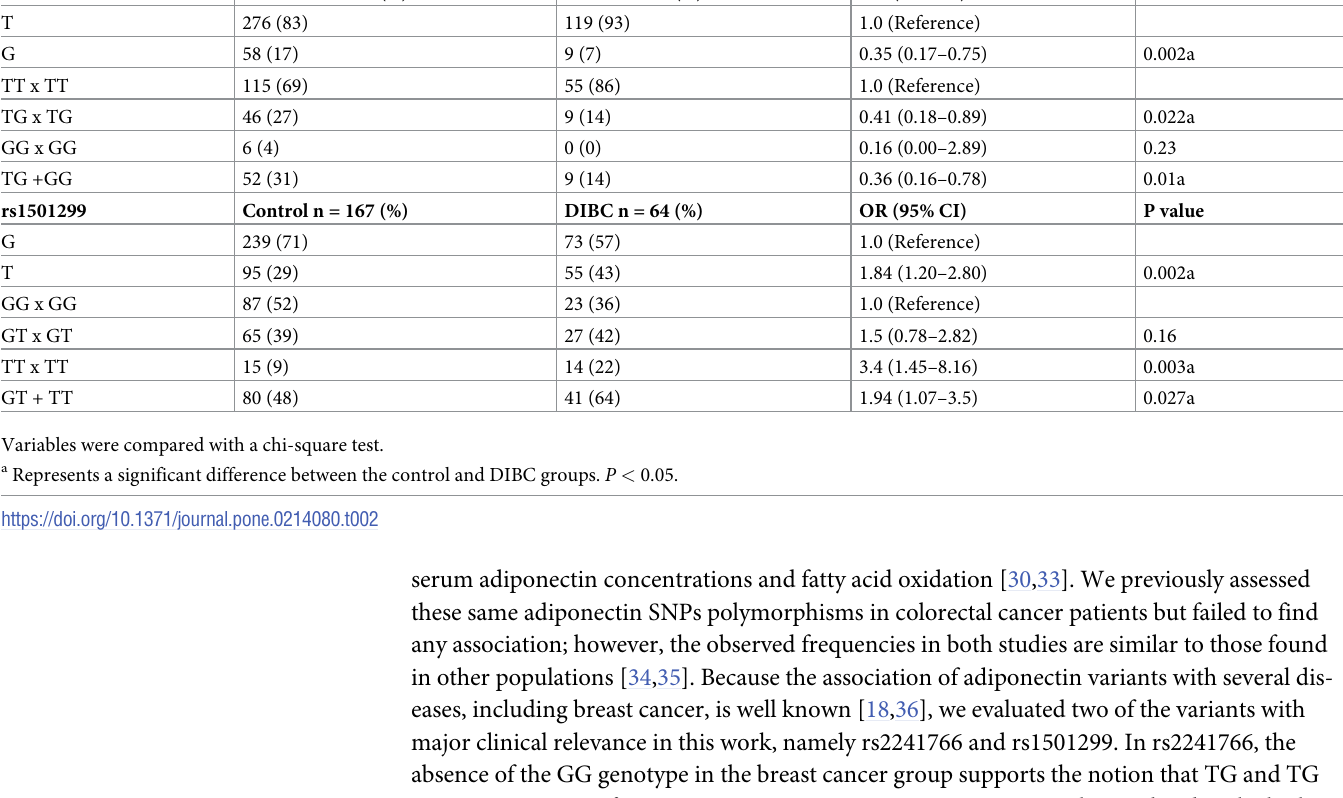
Table 2. Allele and genotype frequencies of ADIPOQ rs2241766 and rs1501299 polymorphisms in control women and those with DIBC. rs2241766